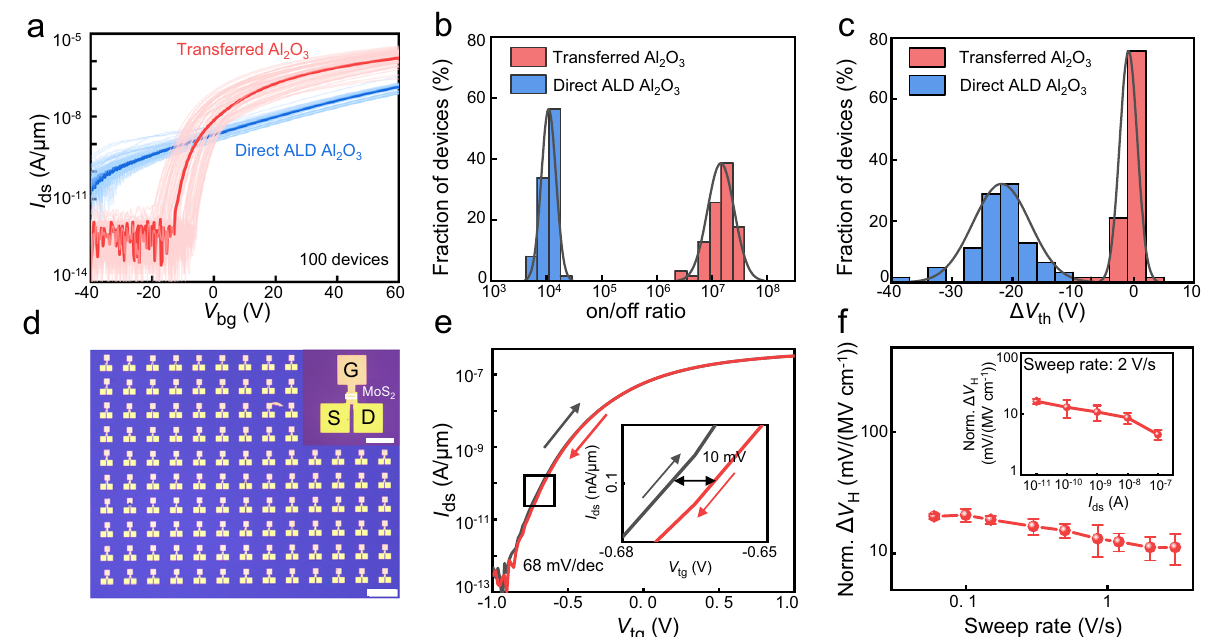
Fig. 3 | Electrical characterization of MoS 2 transistors with transferred dielec- trics. a The I ds – V g transfer characteristic of 100 back-gate MoS 2 transistors with both transferred Al 2 O 3 (red lines) or direct ALD Al 2 O 3 (blue lines) with the repre- sentative MoS 2 transfer cruve highlighted. b , c The statistic distribution of on/off ratio ( b ) and threshold voltage shift ( c ) of back-gate MoS 2 FETs with transferred Al 2 O 3 and direct ALD Al 2 O 3 , respectively, where the solid line is fi tted through Gaussian fi tting. The devices with transferred dielectric exhibt higher on-off ratio, minimized doping effect. d Optical image of top-gate MoS 2 transistor array